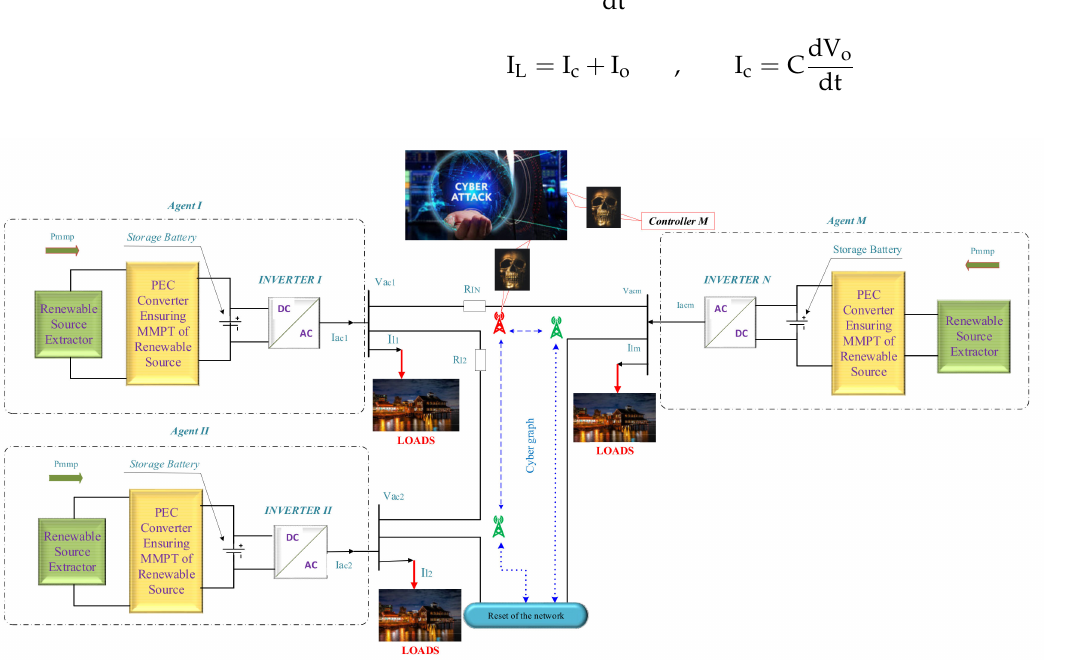
Figure 2. Typical CPS sample of AC-ISMG.